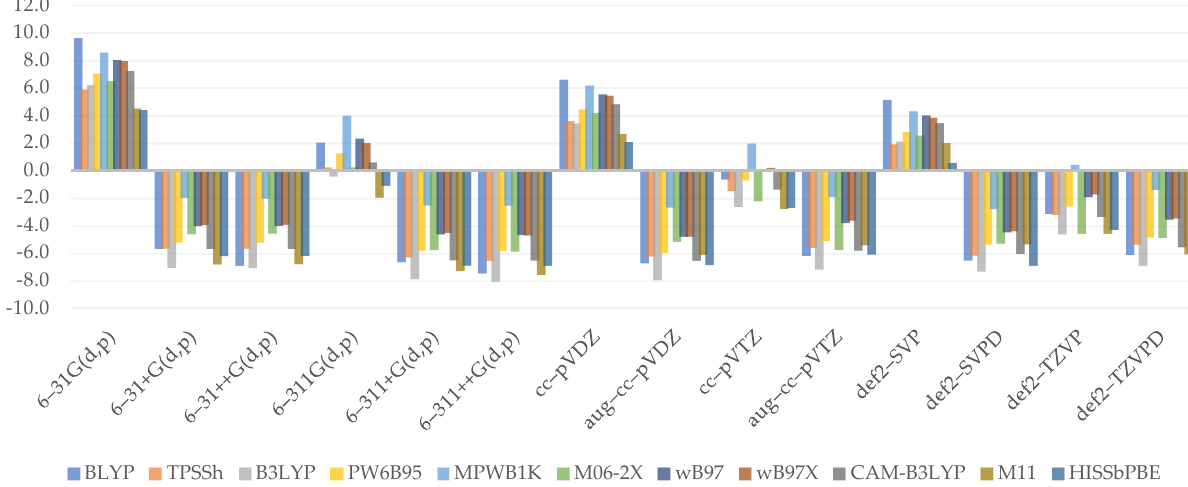
Figure 4. Relative errors to reference value for adiabatic electron affinity (kcal/mol).